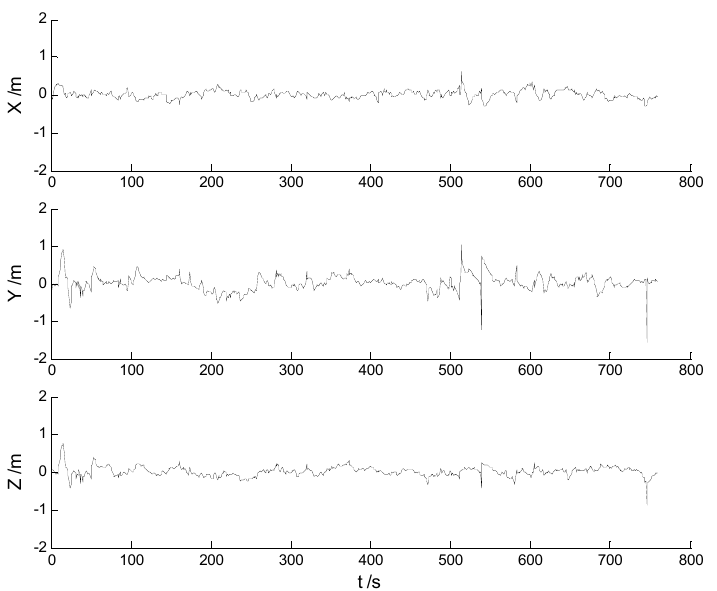
Figure 3. Position errors of the HF-CKF algorithm.